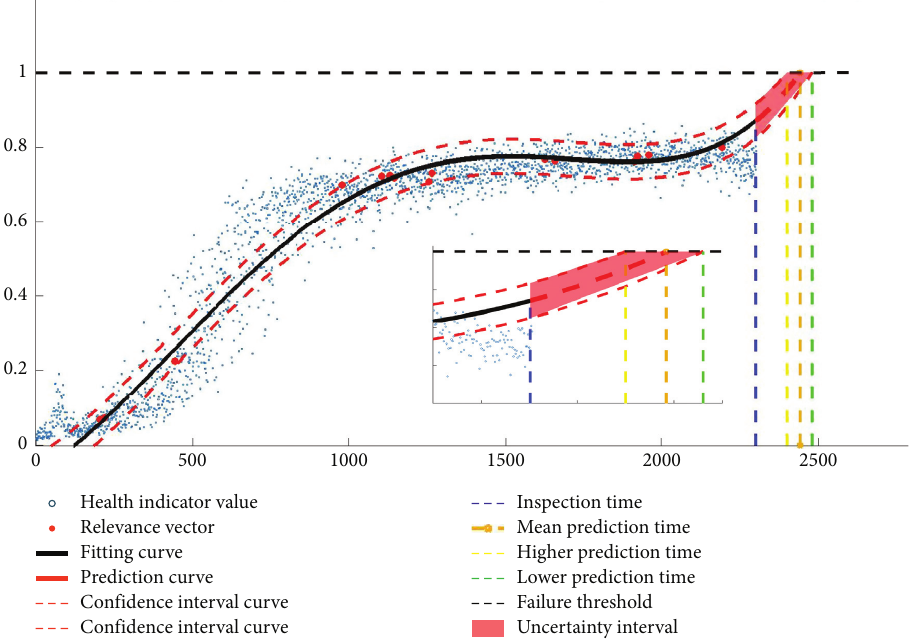
Figure 5: RUL prediction result of bearing 1_5 at inspection time T �